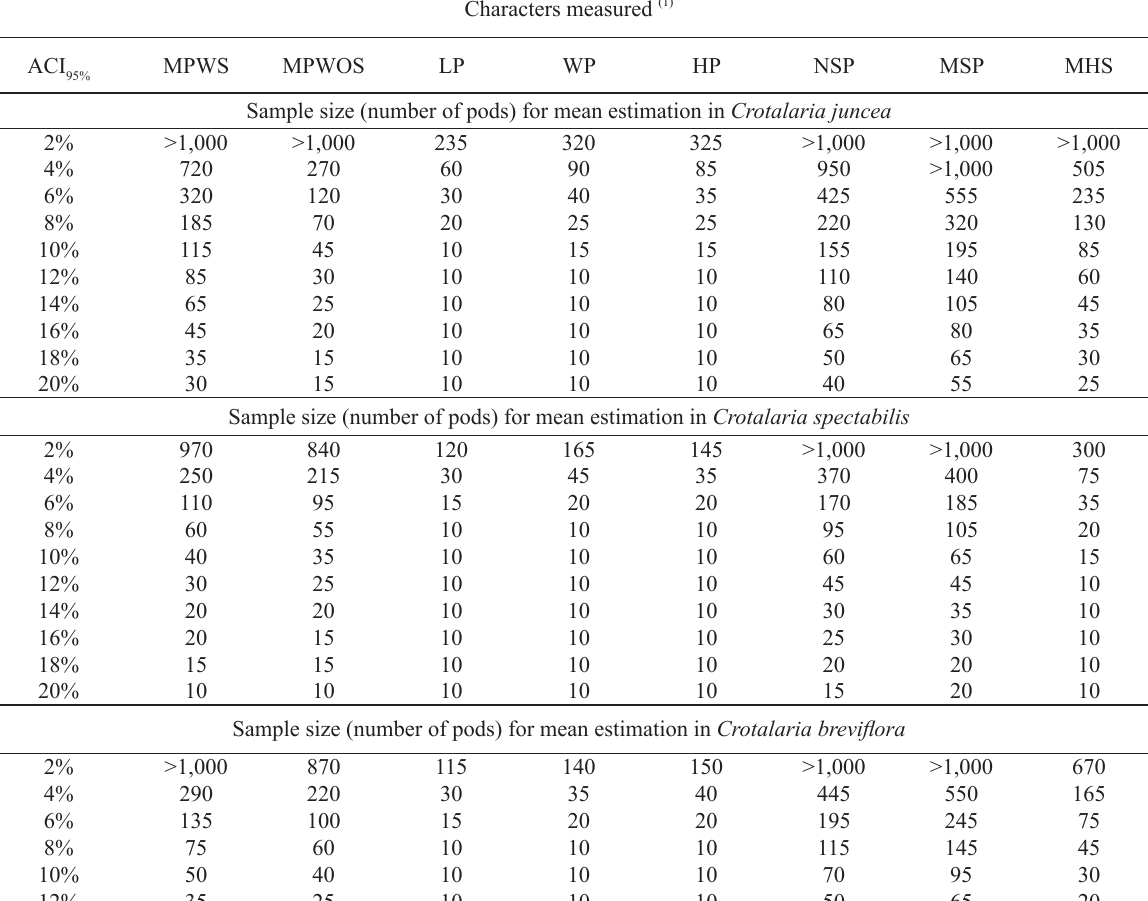
Sample size (number of pods) by resampling with replacement, to estimate the mean of eight characters measured in four species of crotalarias - C. juncea , C. spectabilis , C. breviflora and C. ochroleuca - in the season of 2014/15, for the amplitudes of the confidence interval of 95% (ACI ) equal to 2%, 4%, ..., 20% of the 95%